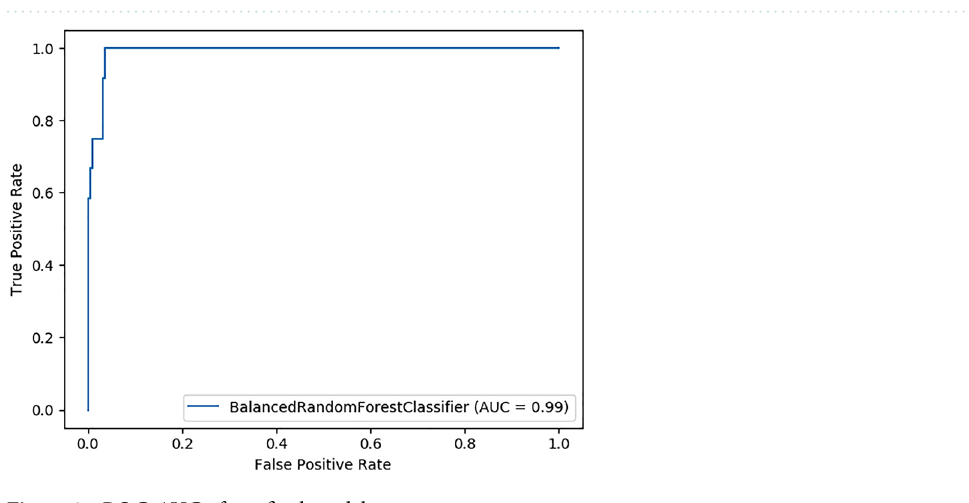
Figure 2. ROC-AUC of our final model.